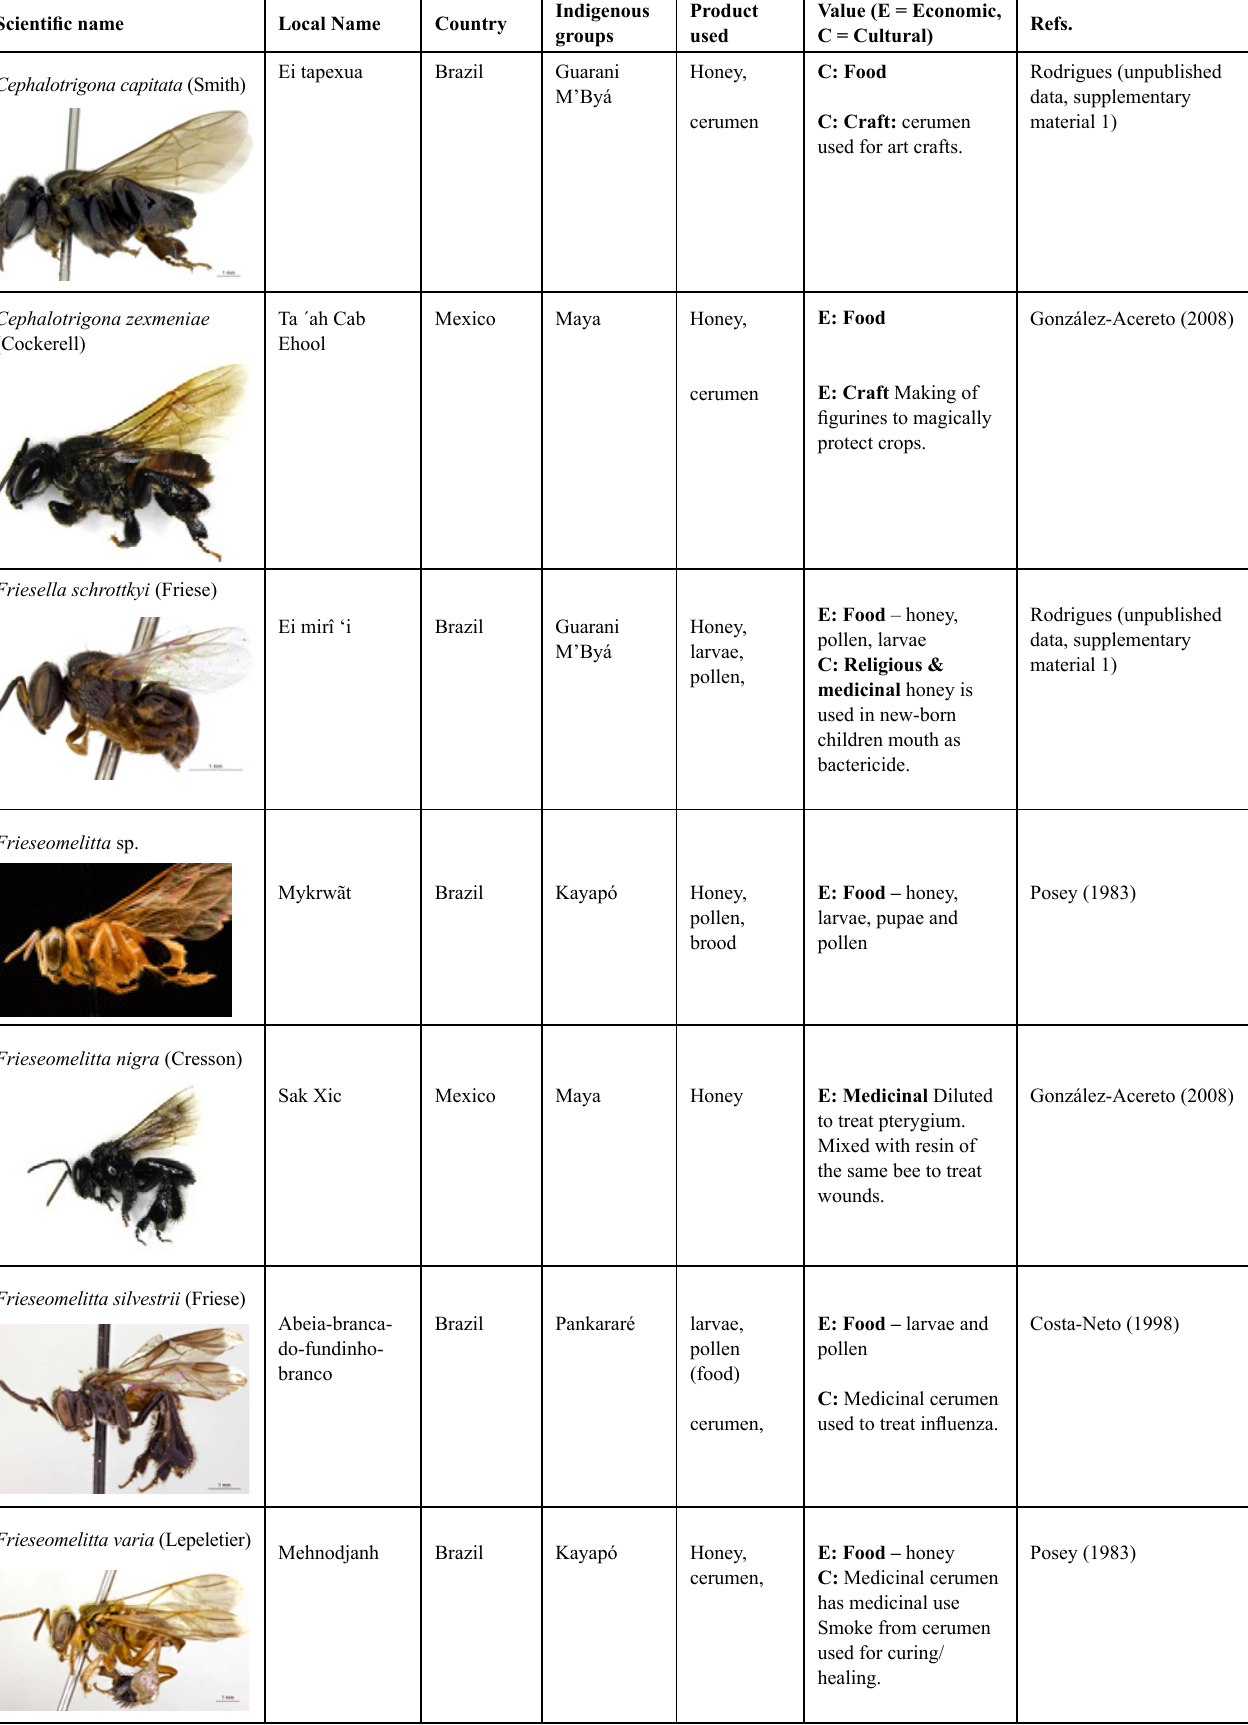
C: Craft: cerumen used for art crafts.